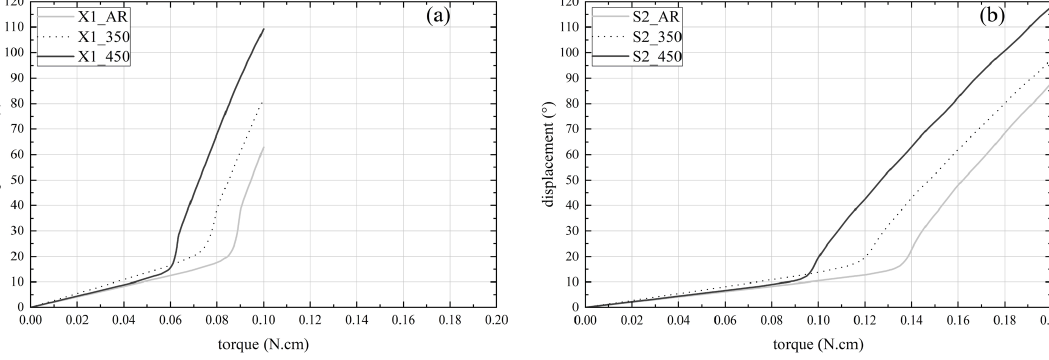
Figure 7. Numerical displacement-torque curves: (a) X1 file and their respective heat treatment conditions and (b) S2 file and their respective heat treatment